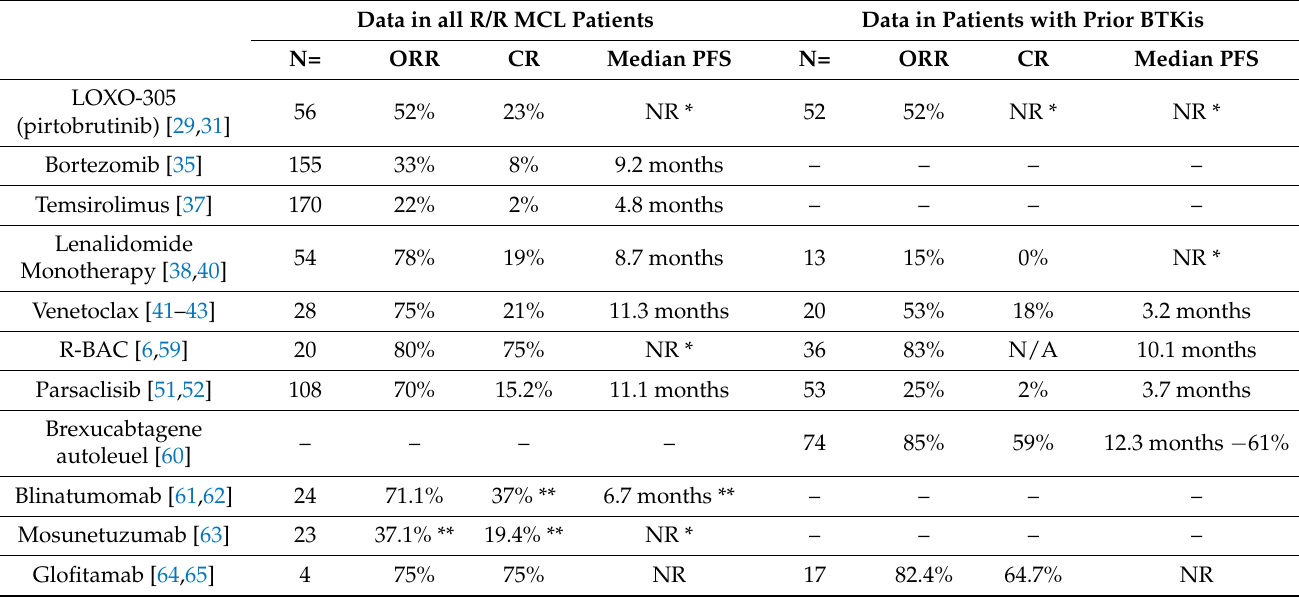
Table 3. Available treatment for R/R MCL and after BTK inhibitor